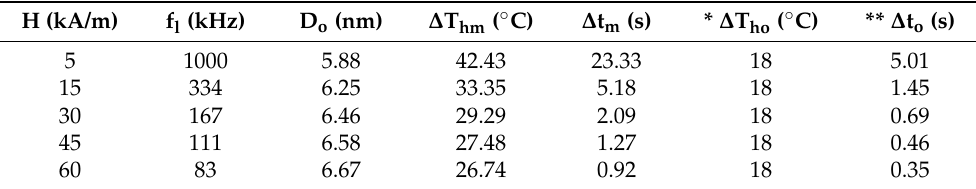
Table 4. The values of the optimal heating times ( ∆ t o ) of the CoFe 2 O 4 nanoparticles under the optimal parameters given in Table 3, for the volume fraction of 0.15. The table also shows the values of the maximum variation of the heating temperature ( ∆ T hm ) of the nanoparticles and their corresponding durations ( ∆ t m ) under the given conditions.